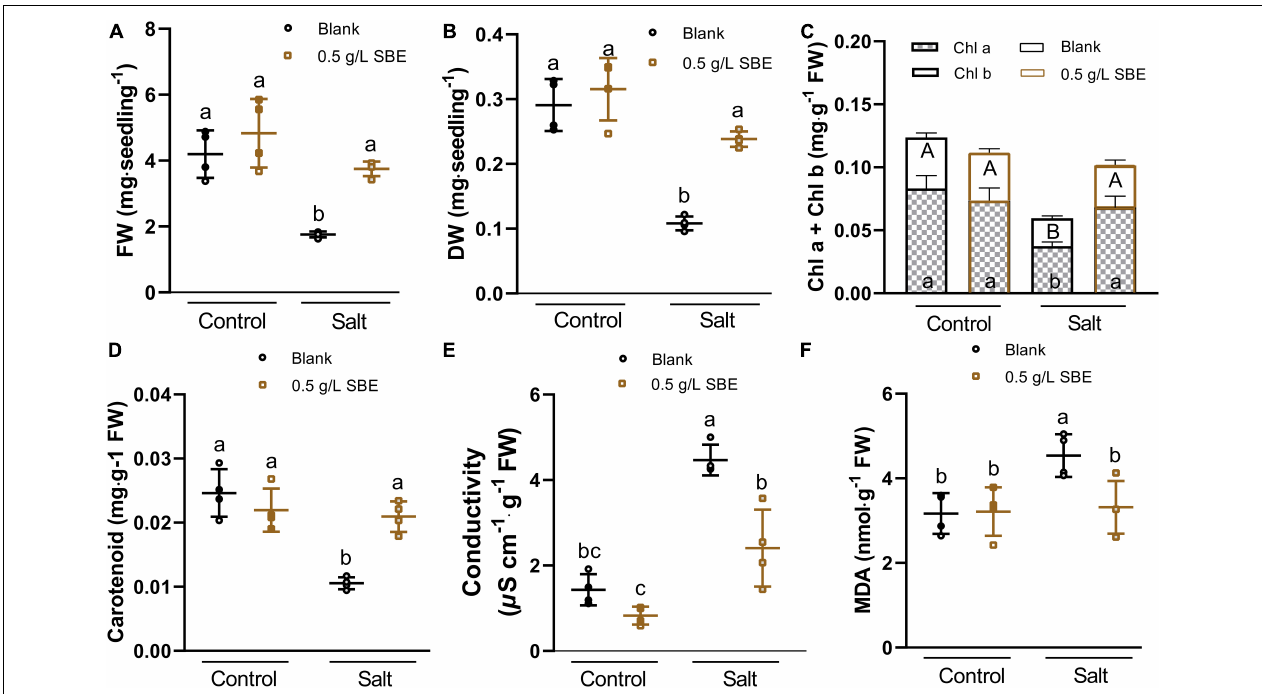
FIGURE 5 | Salt stress alleviation of SBE treatment on the physiological traits of 10 DAG Arabidopsis in the true leaf assay. (A) Fresh weight, and (B) dry weight of the whole seedlings at 10 DAG. The changes of photosynthetic pigments containing (C) chlorophyll a and b, (D) carotenoid content, (E) conductivity, and (F) MDA content. Error bars indicate SDs of the means ( n = 4). Different letters represent significant differences between treatments using Tukey’s HSD test ( p < 0.05). SBE, sunflower bark extract; DAG, days after germination; FW, fresh weight; DW, dry weight; Chl a, chlorophyll a; Chl b, chlorophyll b; MDA,